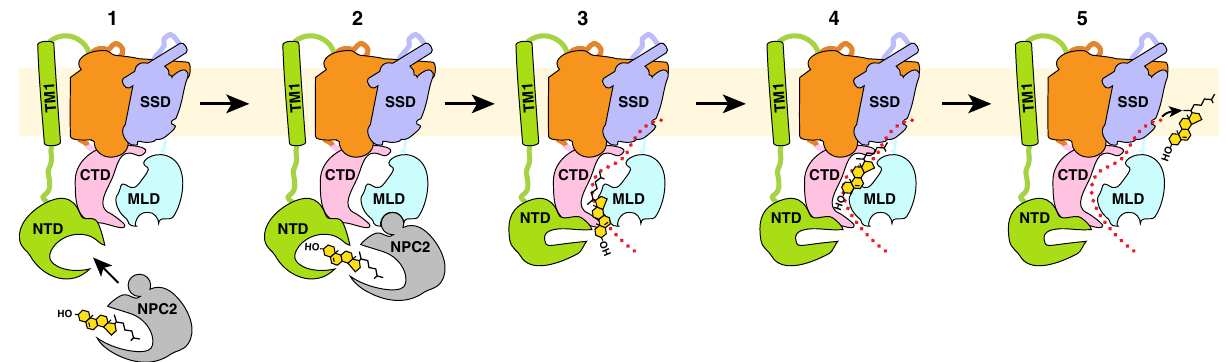
Fig. 7 A working model of NPC1/NPC2-mediated LDL-derived cholesterol transport out of lysosomes. NPC2 protein is shown in gray, cholesterol is shown in yellow, and the putative tunnel of NPC1 is indicated by the red dashed